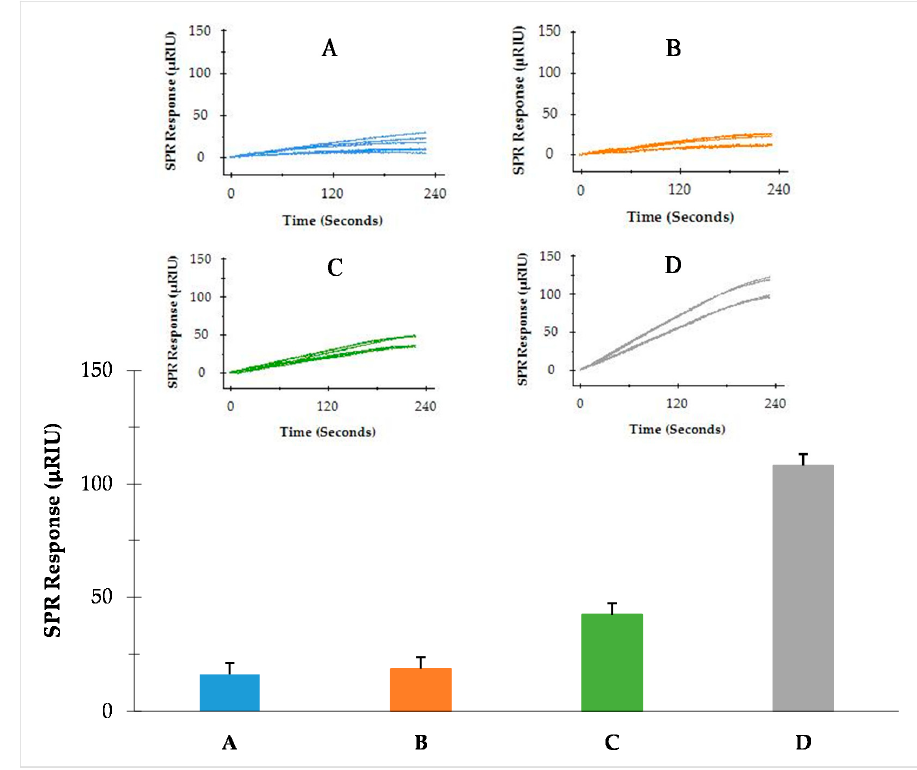
Figure 4. SPR responses of S. Typhimurium at various concentrations ( A ) 5.0 log cfu/mL, ( B ) 5.2